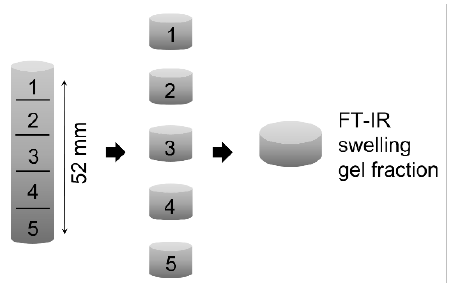
Figure 5. Sectioning of test specimen to evaluate depth-dependent curing.